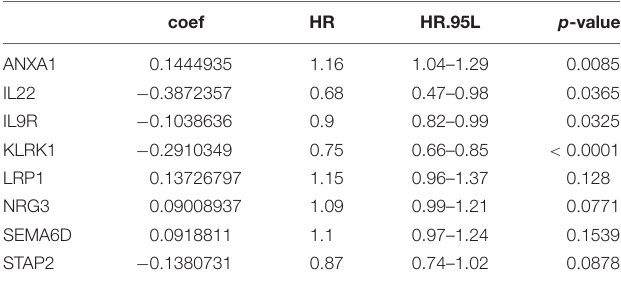
TABLE 1 | Characteristics of differentially expressed immunity genes (DEIGs) in the risk